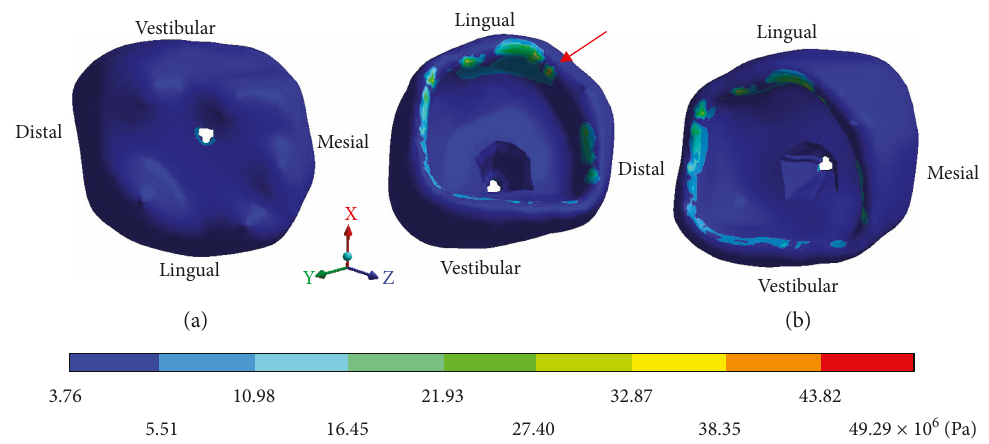
Figure 12: 2nd degree caries : von Mises stresses in enamel: (a) occlusal view (b) cervical view.